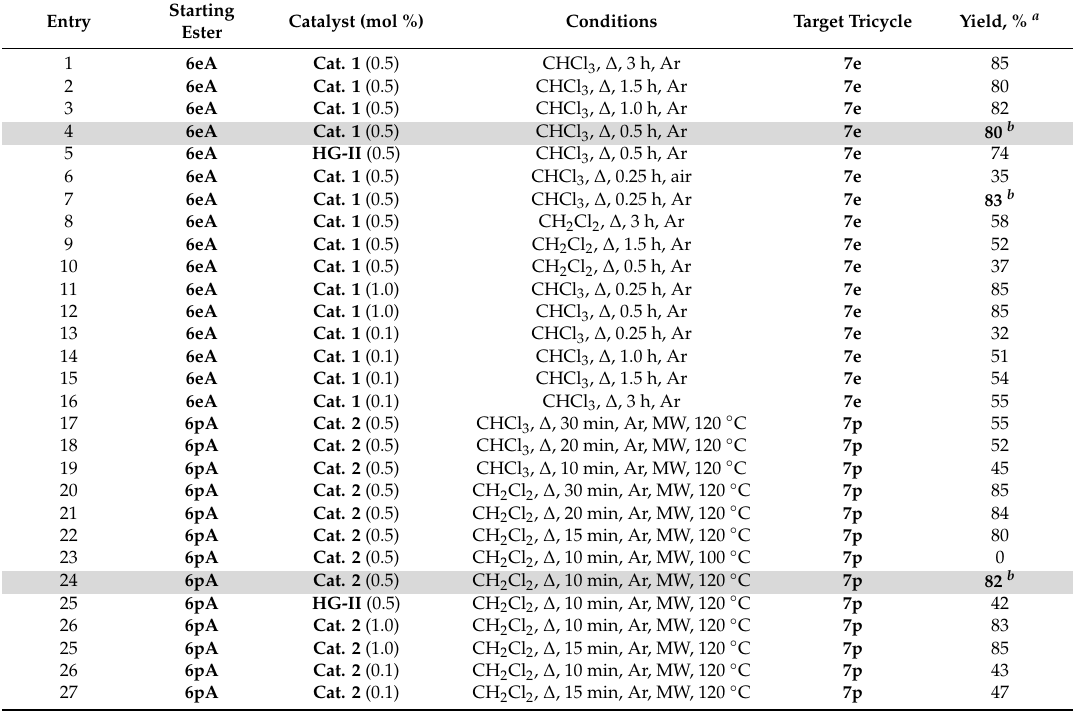
Table 4. Optimization of the RRM protocol using the test esters 6eA and